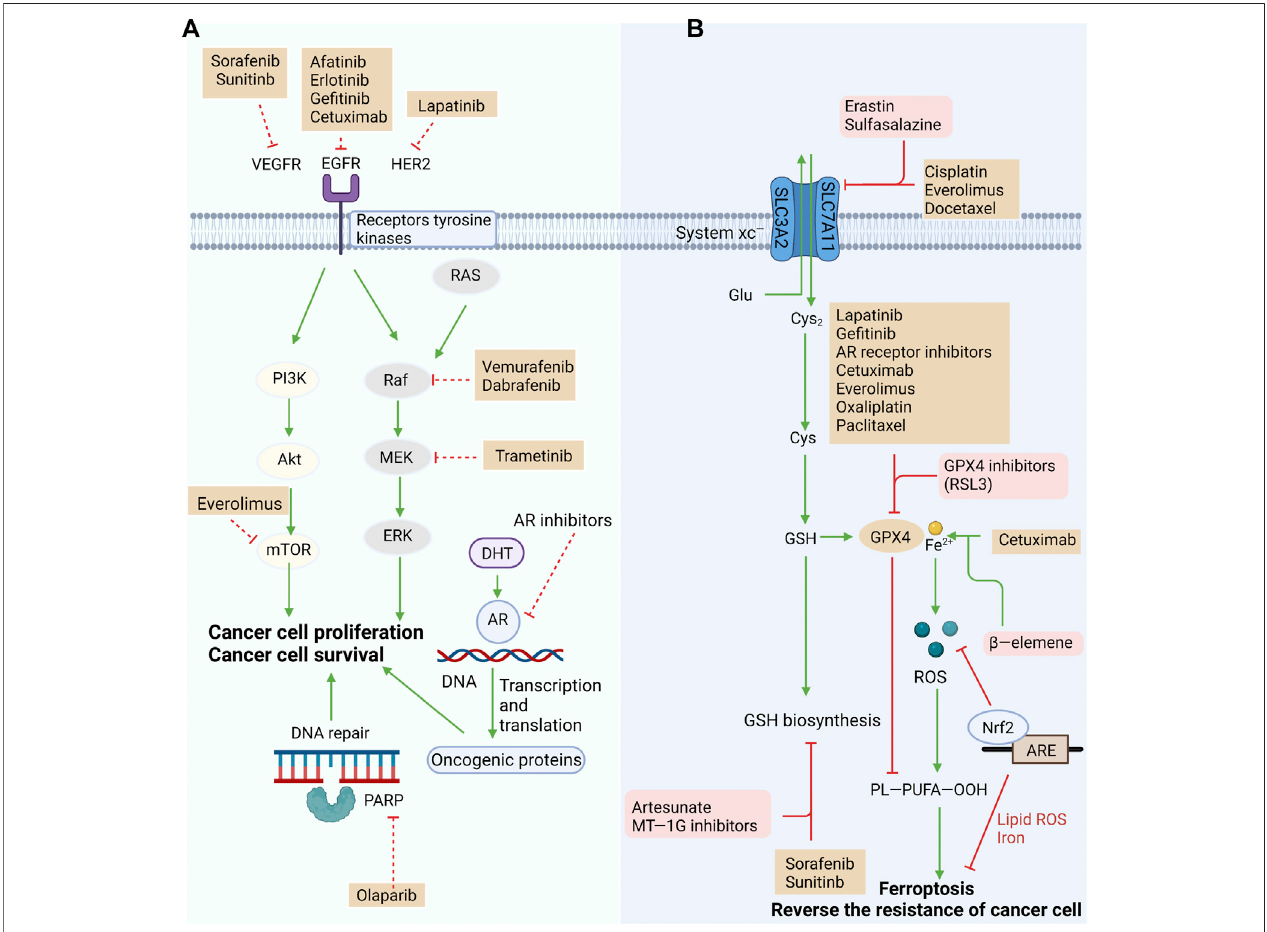
FIGURE 2 | Reversing resistance or enhancing the ef fi cacy of targeted therapy and chemotherapy by targeting the ferroptosis pathway. (A) Targeted drugs exert antitumoreffectsbyblockingoncogenicsignalingpathways,butinnateoracquiredresistancereducestheiref fi cacy. (B) Oneofthemechanismsofresistanceisreduced susceptibilitytoferroptosis.Targetingmultiplepathwaysinferroptosistorestoretheirresponsetoferroptosiscouldeliminateresistanceorimprovetheef fi cacyofexisting standard treatments, including chemotherapy and targeted therapy. System Xc − and GPX4 have critical roles in preventing ferroptosis and potential targets to reversetreatmentresistance.Otherfactorsthatregulatetheredoxofintracellularlipidarealsohavecriticalrolesinanticancertreatmentresistance.Manyapproveddrugs target those potential targets and may reverse the resistance by exploiting ferroptosis pathway.